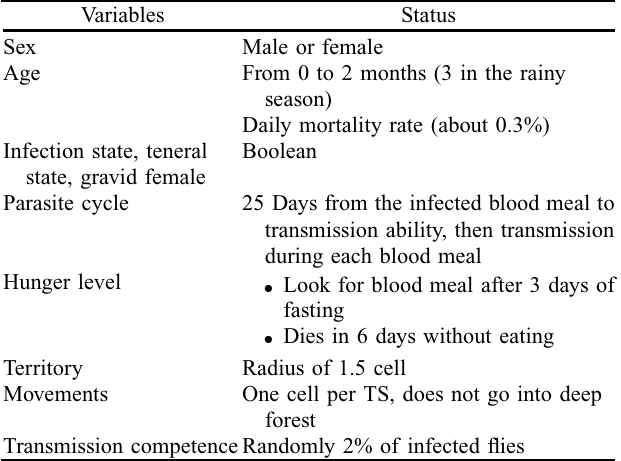
Table 3. Attributes and status of tsetse fly